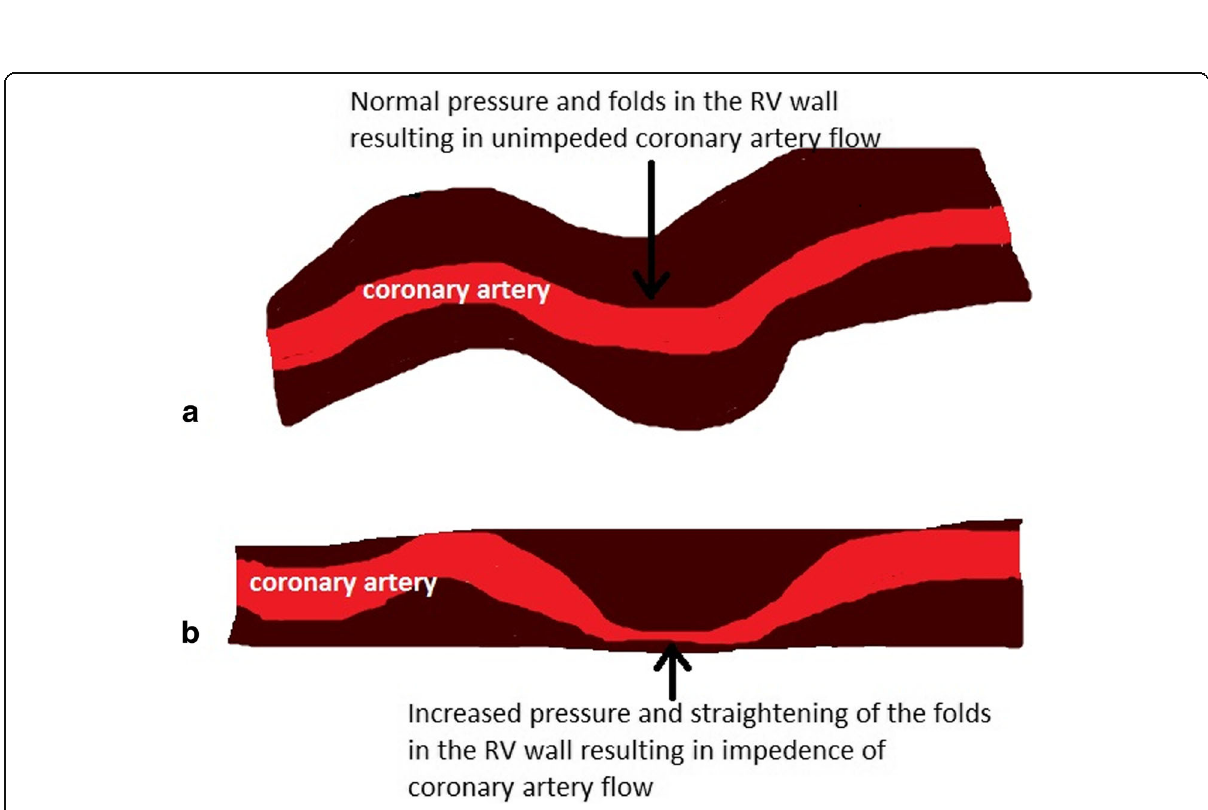
Fig. 5 Pictorial depiction of the compromise of the coronary arteries. a Depicts uninhibited flow of blood through a coronary artery as it passes through the folds (arrow) of the right ventricular wall. b Depicts a coronary artery with region of stenosis due to straightening of the folds in a dilated RV